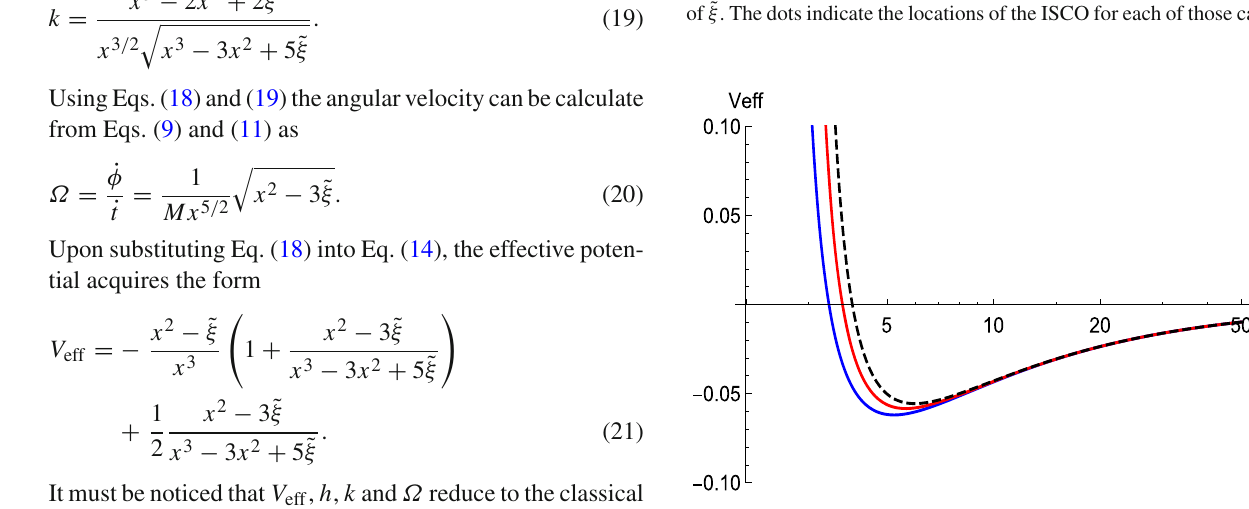
Fig. 3 The effective potential V eff vs. x for several values of ˜ ξ = ξ/ M 2 . From left to right: ˜ ξ = ˜ ξ = 16 / 27 (blue), ˜ ξ = 0 . 3 (red). The c classical case ˜ ξ = 0 is given by the black dashed